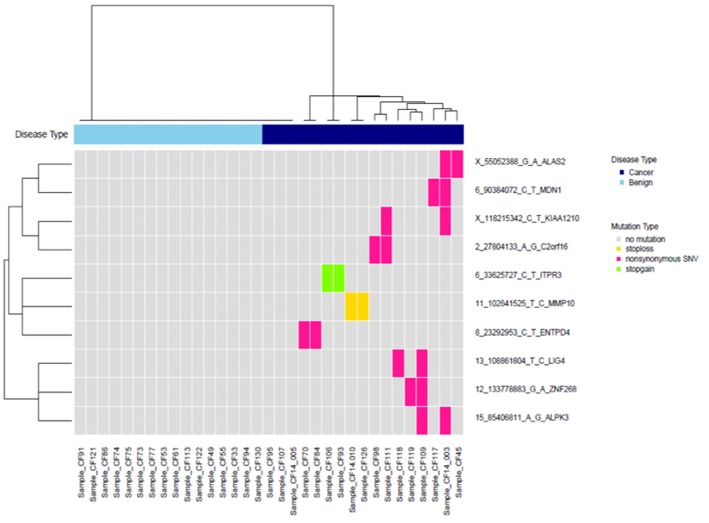
Clustering of 10 high-confidence somatic variants observed in at least two patients with cancer, but not in the control group.